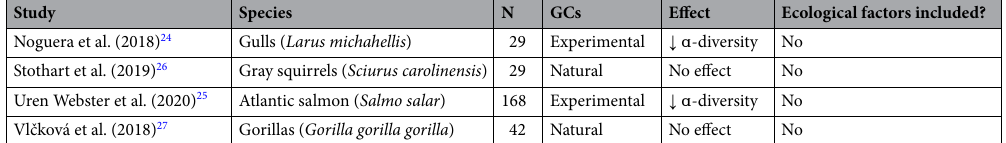
Table 1. Selected prior experimental and correlational studies on the relationship between glucocorticoids and gut microbiome alpha diversity in captive and wild vertebrates.